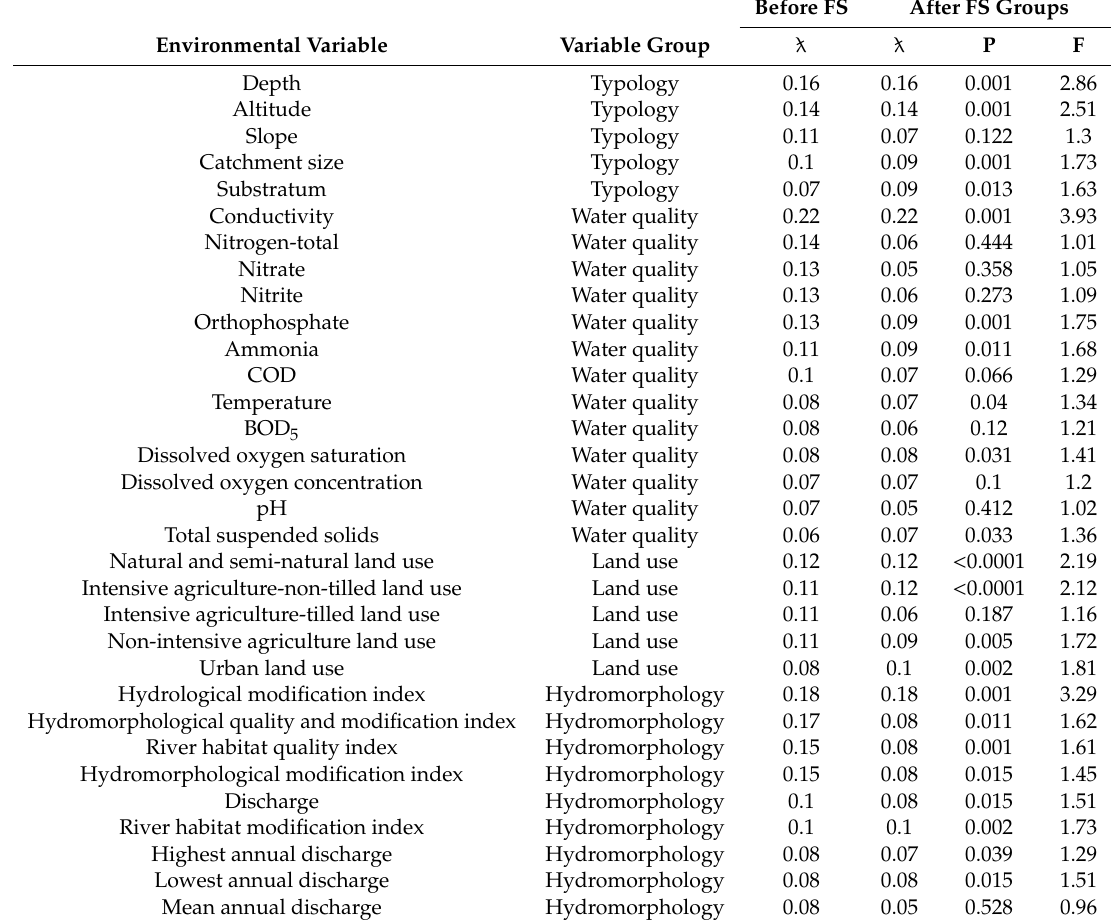
Table 3. Percentage of benthic invertebrate assemblages variance explained by each environmental variable’s independent (before forward selection) and conditional e ff ects (after forward selection within each environmental variable